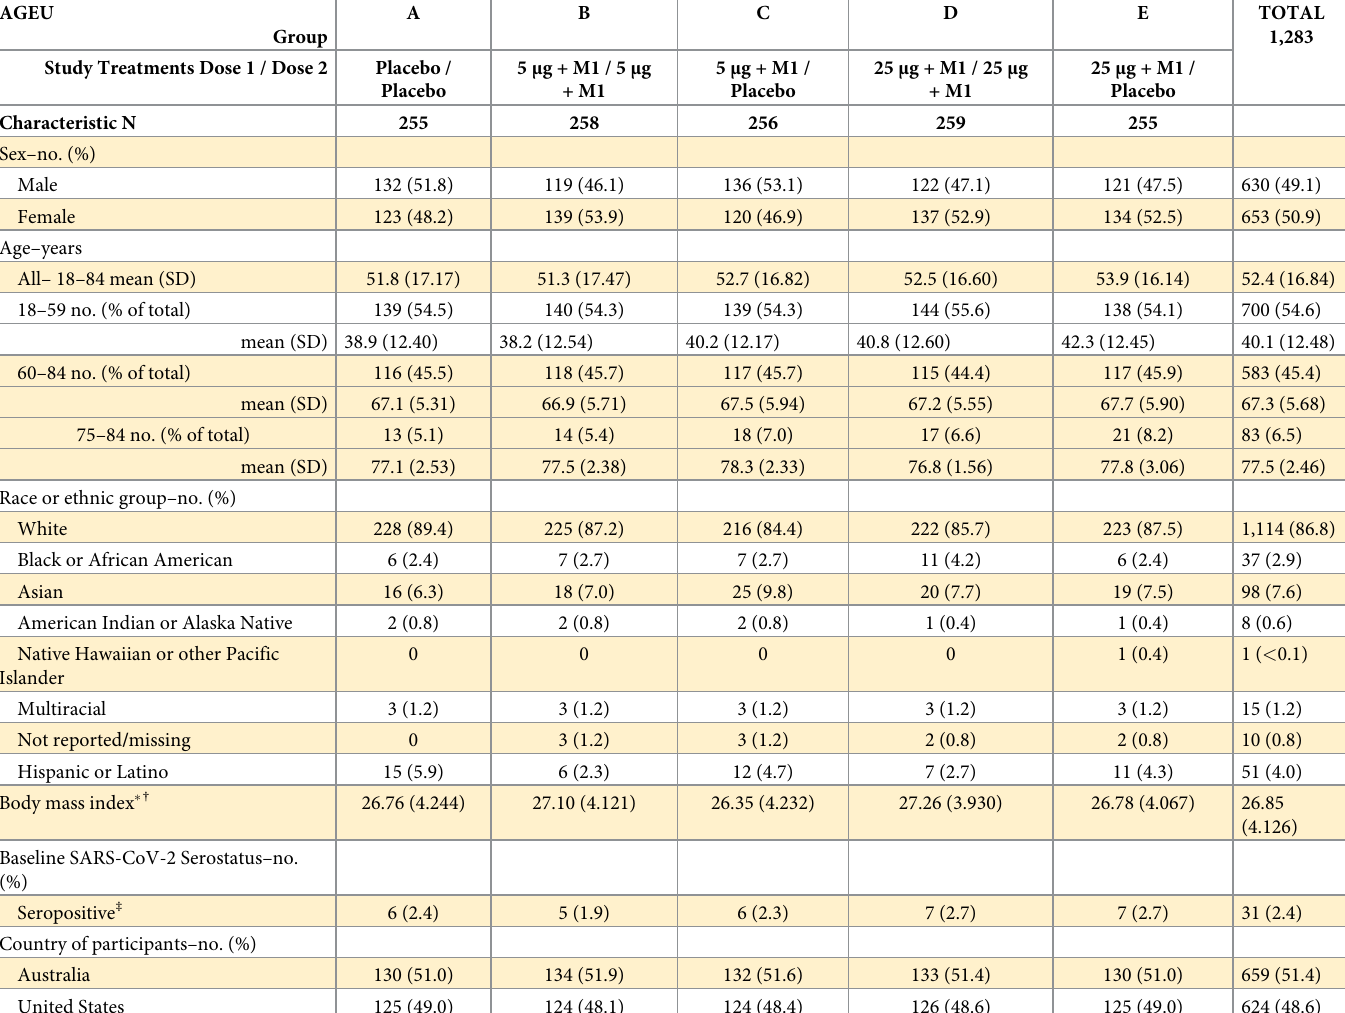
Table 1. Demographic characteristics of the participants at enrollment (Safety Analysis